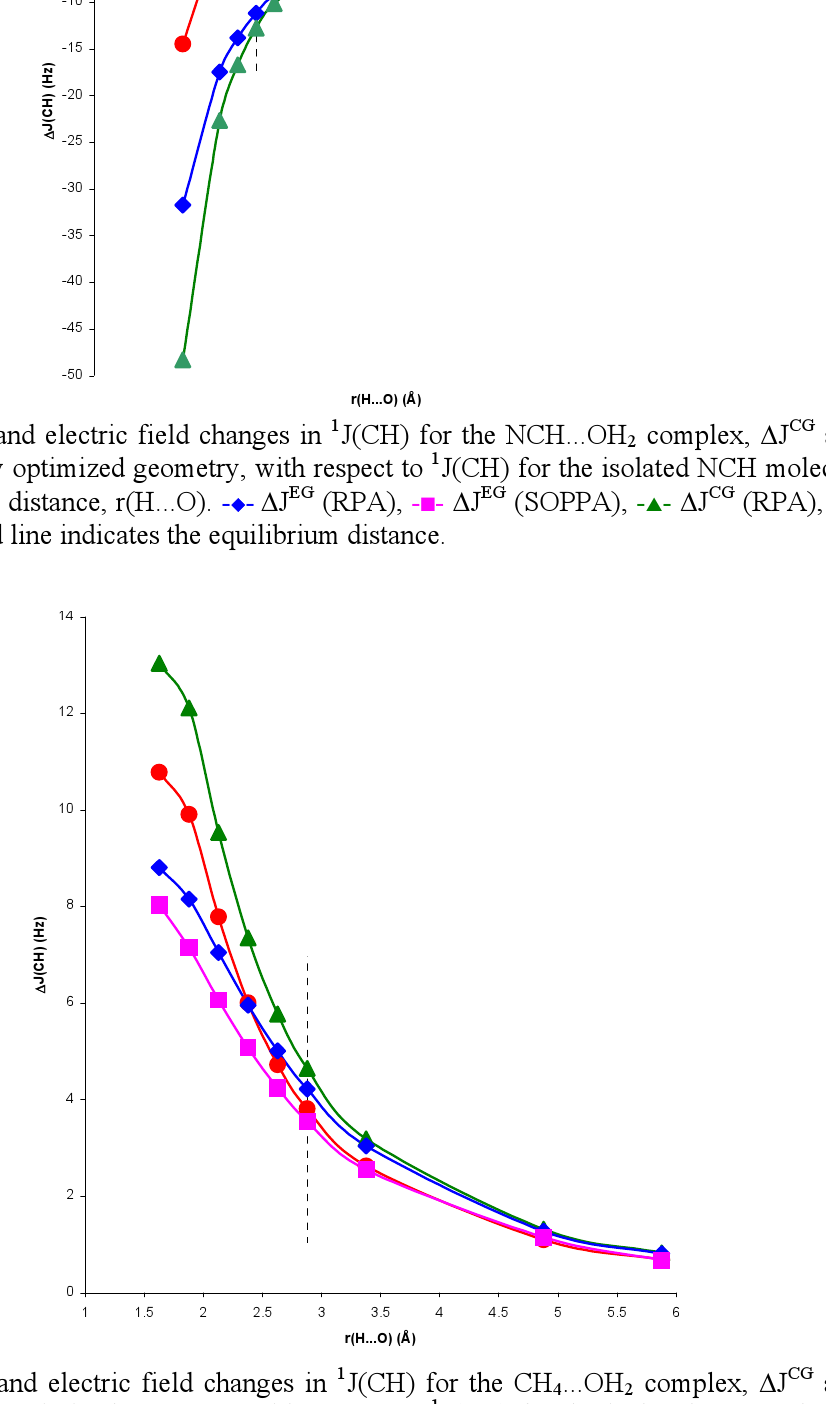
...OH complex, ∆ J CG and ∆ J EG 4 2 molecule, as a 4